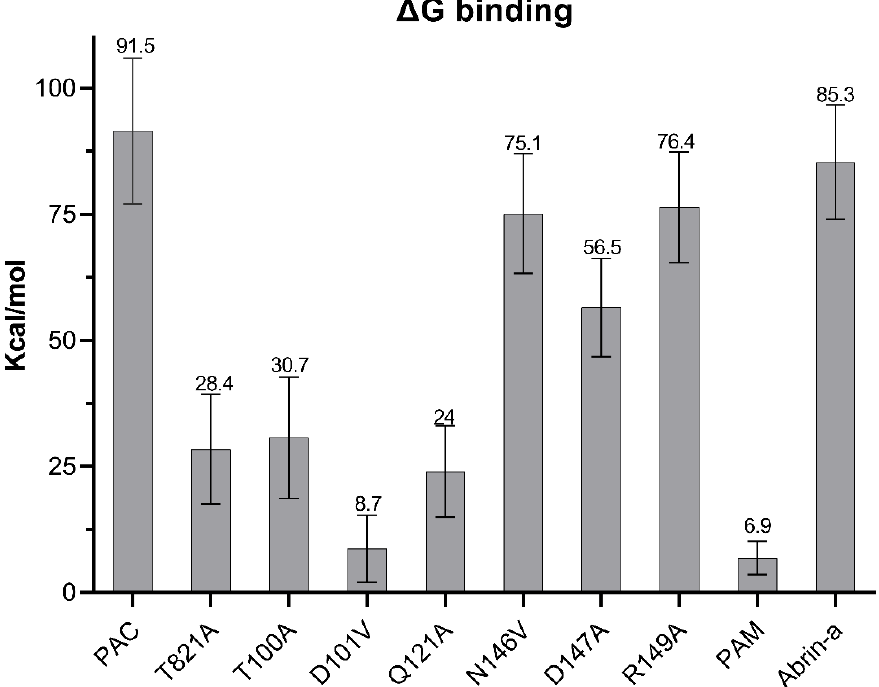
Figure 6. Binding free energy of complexes. For 500 frames taken from the last 5 ns of the MD simulation, binding free energy was calculated using the gmx_MMPBSA tool. In comparison to Abrin-A and other mutants, the PAM in interaction with the ligand represented a significant amount of binding